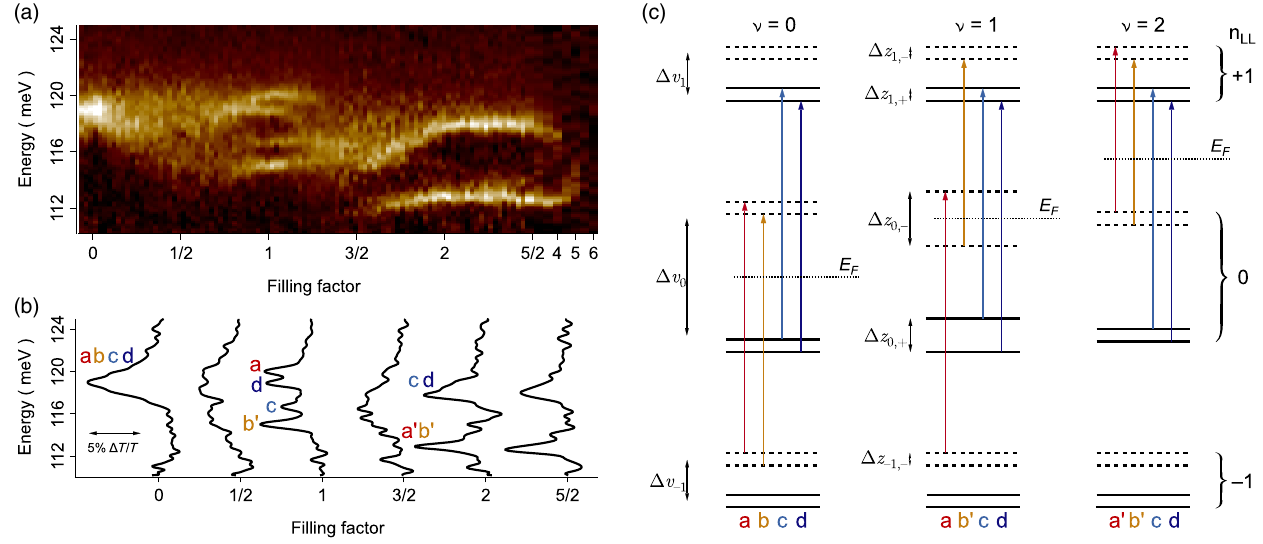
FIG. 2. Evolution of transition T 1 vs filling factor. (a) High-resolution map of T 1 vs filling factor from ν ¼ − 0 . 07 to ν ¼ þ 2 . 5 . Traces were acquired every δν ¼ 0 . 026 , with additional traces at ν ¼ 3 ; 3 . 5 ; … ; 6 . Starting with a single bright peak at ν ¼ 0 , four peaks appear near ν ¼ þ 1 , which reduce to two peaks at ν ¼ 2 and higher. By ν ¼ 6 , the T 1 transition is extinguished as the participating LLs are filled. (b) Detail of transitions by line cuts at half-integer fillings. The linewidths at ν ¼ þ 1 are the narrowest observed, with τ CR reaching 2.5 ps, or a resonance quality factor Q ¼ 220 . In between integer values of ν , only a single broad resonance is resolved. (c) Schematic of transitions involving the n ¼ − 1 , 0, and þ 1 LLs. Solid (dashed) lines indicate the K ( K 0 ) valleys, with valley gaps Δ v i and spin splittings Δ z explicitly included. The Fermi energy E is shown as a dotted line. Each of the four spin and valley-preserving i F CR transitions are shown in different colors, corresponding to the labels a , b , c , and d . As the filling factor is increased, the two transitions from n ¼ − 1 to 0 become Pauli blocked and are replaced by transitions from n ¼ 0 to þ 1 ; this is indicated by a label change a; b → a 0 ; b 0 . Gaps indicated in this schematic represent single-particle levels enhanced by electron-electron interactions as discussed in the